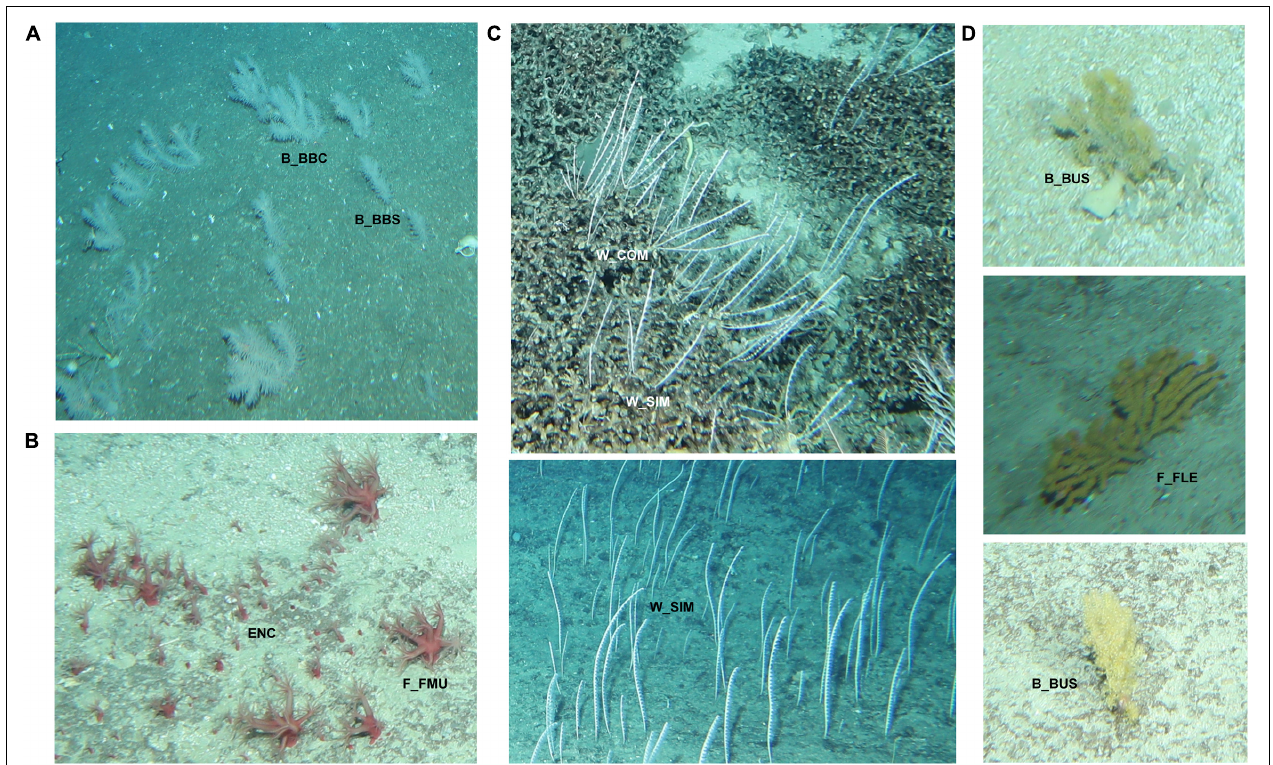
FIGURE 3 | Morphological character variation of selected black and octocoral phototaxa. Ontogenetic variation in (A) Thouarella (phototaxon 10) (B) Alcyoniidae (phototaxon 23). Morphological variation due to environmental and image related factors in (C) Aurogorgia tasmaniensis (phototaxon 7), and (D) Acanthogorgia (phototaxon 29). B_BBC, Bottle-brush: complex; B_BBS, Bottle-brush: simple; ENC, encrusting; F_FMU, Fleshy: mushroom; W_COM, whip: complex; W_SIM, whip: simple; B_BUS, Branching (3D): Bushy; F_FLE, Fan(2D)